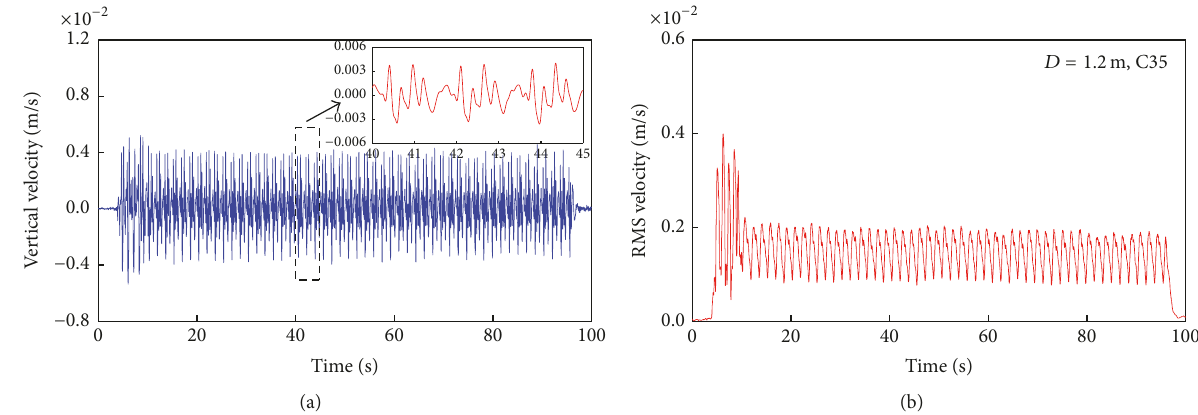
Figure 6: Sleeper vibration velocity due to the passage of T32 at speed of 28 km/h: (a) time history and (b) running rms.